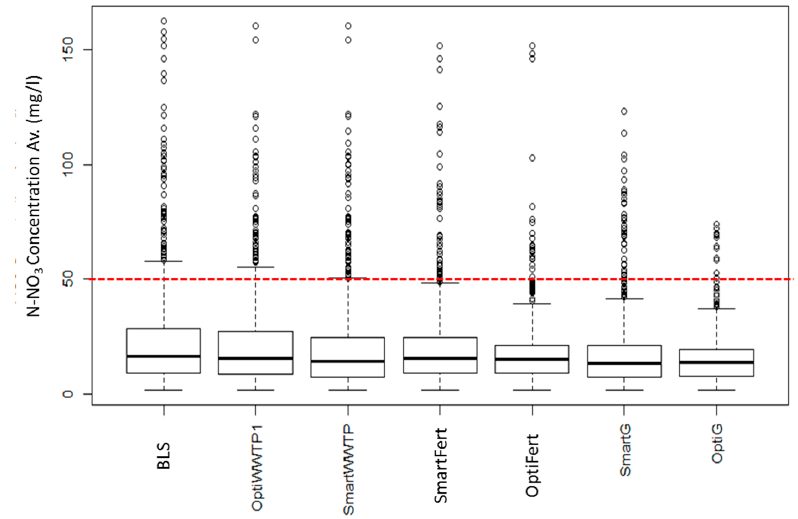
Figure 8. Boxplot of reach mean N ‐ NO 3 concentration (mg/L) in the Upper Danube Basin under alternative management strategies.